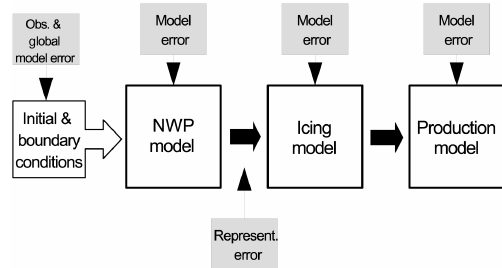
Figure 1. The modelling chain for forecasting icing-related produc- tion losses. Uncertain parts are pointed